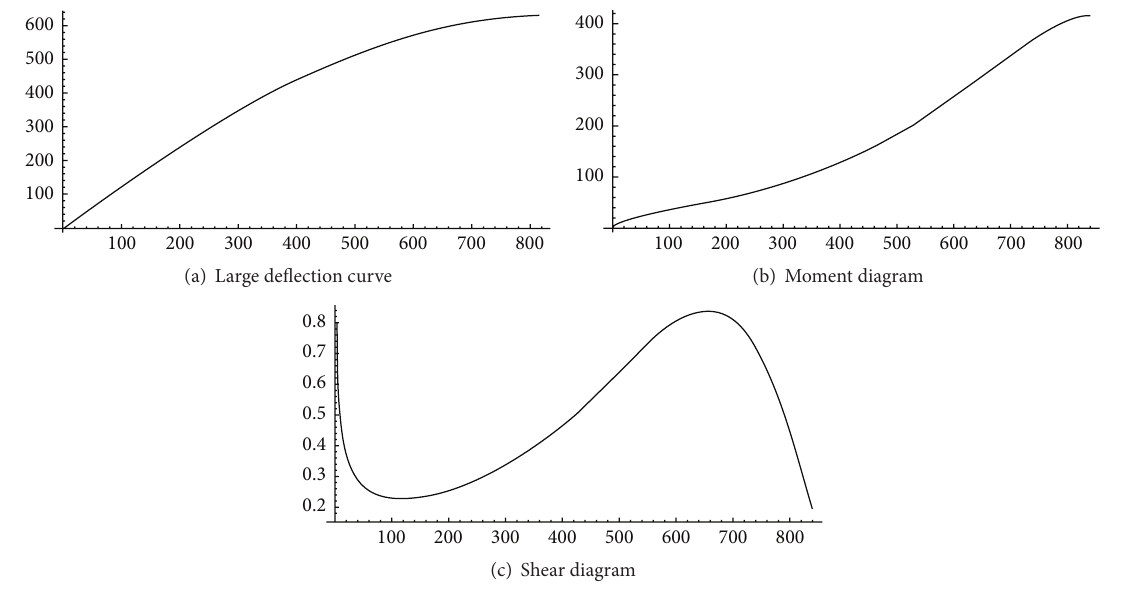
Figure 3: Numerical results of deformation via LADM ( 4